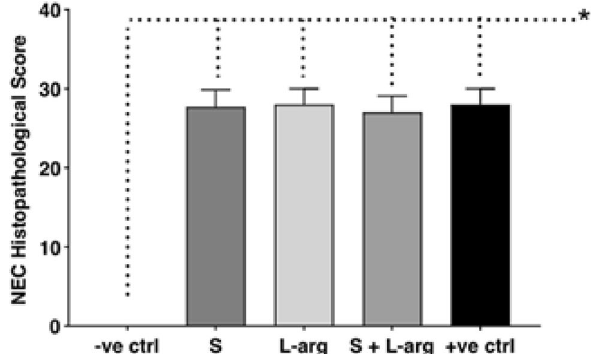
Figure 3. Mean histopathological injury score of the groups. Groups: A—negative control (− ve ctrl), B— sildenafil (S), C—l-arginine (l-arg), D—sildenafil and l-arginine (S + l-arg) and E—positive control (+ ve ctrl) (Kruskal–Wallis, p = 0.0288).